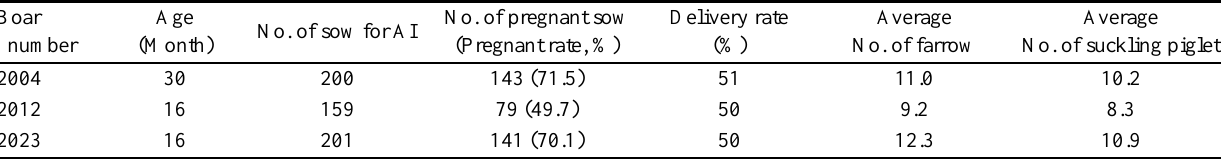
Table 1. Breeding performance of semen from boar number 2004, 2012, and